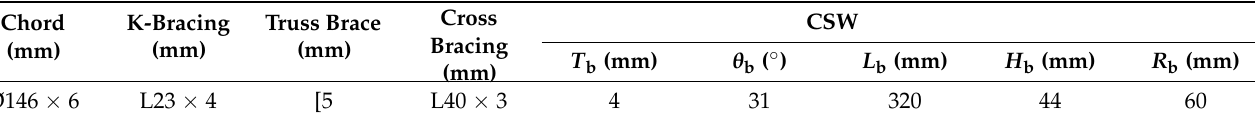
Table 1. The degrees of freedom in the X and Z directions of one end of the test model were constrained, and only the degree of freedom in the Z direction of the other end of the test model was constrained. Table 1. Summary of geometric parameters of the test model. Table 1. Summary of geometric parameters of the test model.